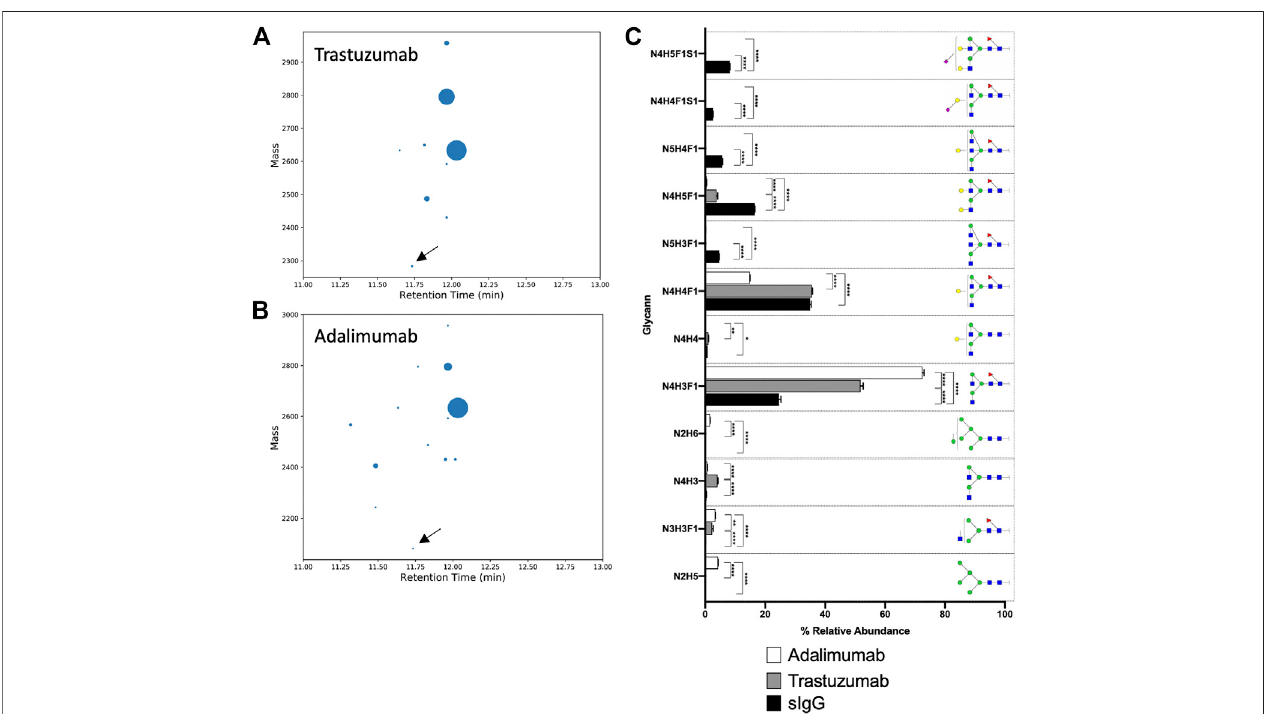
FIGURE4| BubblechartofthedeconvolutedmassofglycoformsofEEQY N STYRof (A) trastuzumab,and (B) adalimumab,againsttheirrespectiveretentiontime. Identi fi cation of glycan composition was performed using GraphMS. Reference nodes of trastuzumab and adalimumab are labeled with black arrows. (C) Bar chart summarises the relative abundance (in percentage) of glycans of serum IgG, trastuzumab, and adalimumab (only those with relative abundance higher than 0.5% are plotted). (C) ,Two-way ANOVA followedbyBorreroni ’ sposthoctest, multiple comparisonswereperformed betweenserum IgG,transtuzumab,and adalimumab, n (cid:2) 4; * p < 0.05, ** p < 0.01; *** p < 0.001; **** p <